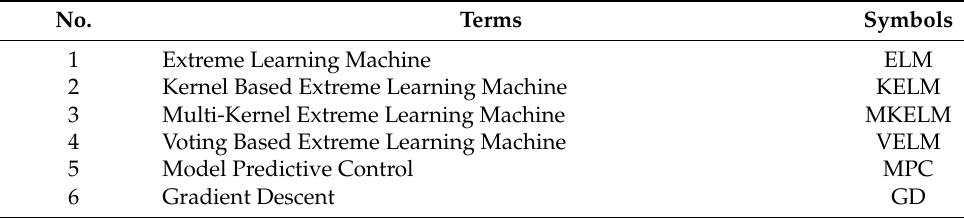
Figure 2. Predictive control framework of the raise boring process using the machine learning method. Table 2. Abbreviations of the Table 1. Nomenclature of the terminologies.